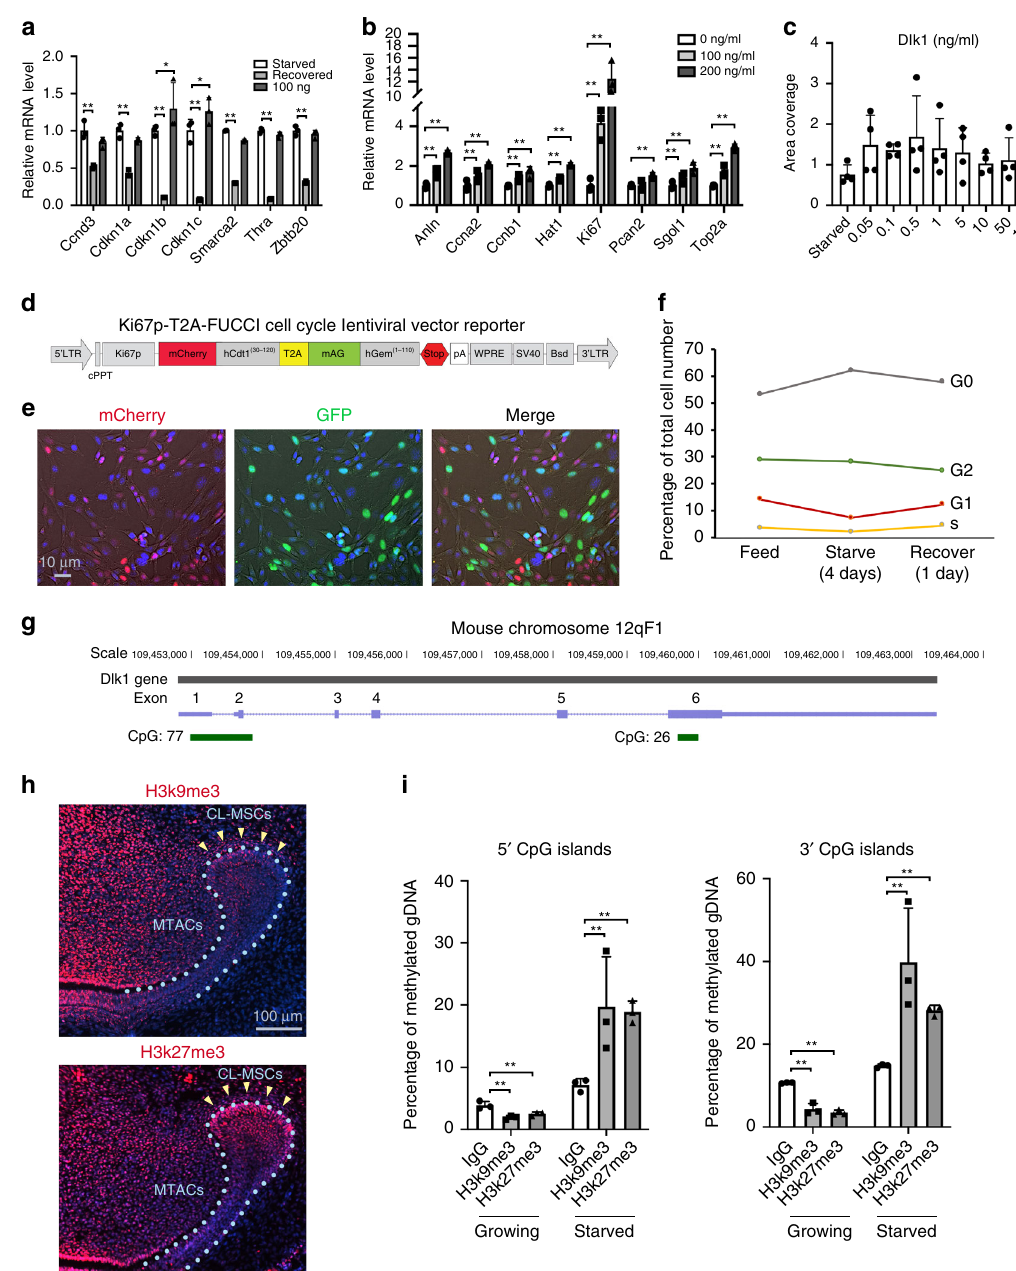
Fig. 7 MTACs feedback to CL-MSCs through Dlk1. a , b Real time RT-PCR analysis of the indicated markers in the MO6-G3 cells cultured under bound ( a , coating the protein onto cell culture dish fi rst before seeding cells) and free form of Dlk1 ( b , by adding directly on top of cultured cells). Cells were starved for nutrients for 4 days before recovery or Dlk1 treatment for 24h as indicated. The results were from n = 3 biologically independent samples. Two- way ANOVA followed by Bonferoni correction was performed. No asterisk: p > 0.05; * p < 0.05; ** p < 0.01. c Colony areas coverage of the soluble Dlk1- reated cells as indicated in b . The results were from n = 3 biologically independent samples. d Design of a new Ki67p-T2A based FUCCI cell cycle indicator. e Representative images of MO6-G3 cells incorporated with the Ki67p-T2A-FUCCI cells. Images were taken under phase contrast setting. f Flow cytometry analysis of MO6-G3/Ki67p-T2A-FUCCI cells at different cell cycle phase under indicated culture condition. g Illustration of genomic location of mouse Dlk1 gene and its 5 ′ and 3 ′ CpG islands (green) and number. The positions of exons are indicated in purple. h Immuno fl uorescence analysis of H3k9me3 and H3k27me3 in the P7 mouse incisor. Nuclei were counterstained with DAPI. Yellow arrows mark clusters of odontoblasts that were EGFP positive. Light blue dotted lines indicate epithelial – mesenchymal junctions. i Methylation analysis of mouse Dlk1 gene CpG islands in the MO6-G3 cells at growing and starved conditions. Genomic DNA were extracted from n = 3 biologically independent samples. Two-way ANOVA followed by Bonferoni correction was performed. ** p < 0.01. Error bars represent standard deviation. Bars: e : 10 μ m; h : 100 μ